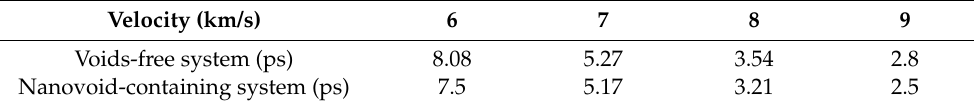
Table 1. The transition induction time of the two systems from the elastic to the plastic stage. Velocity